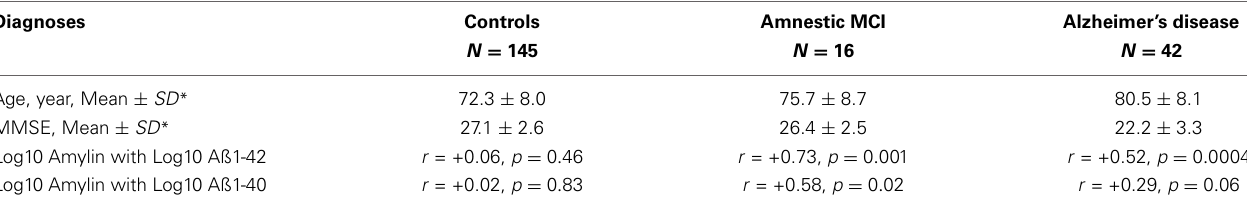
Table 3 | Correlations between A β and Amylin in Plasma in Humans.